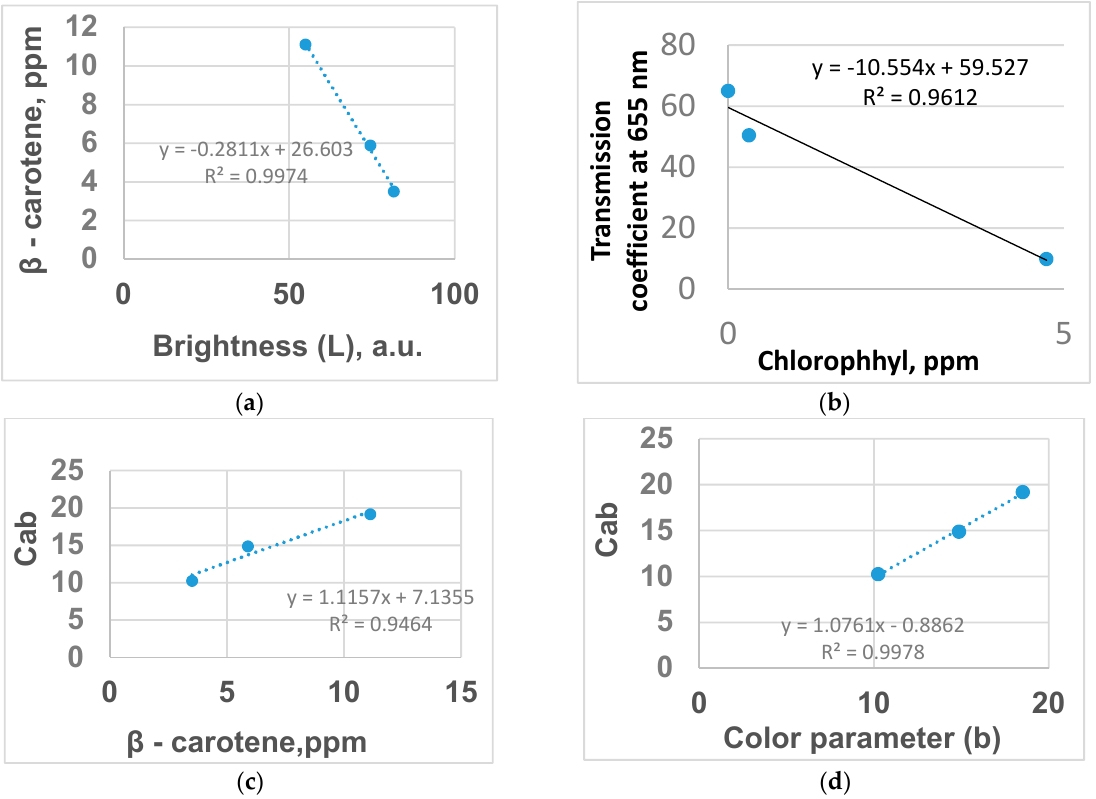
Figure 2. Linear dependances between contents of pigments and color characteristics. ( a ) β -carotene related to brightness; ( b ) Transmission coefficient at 655 nm related to chlorophyll; Cab related to: ( c ) β -carotene and ( d ) color